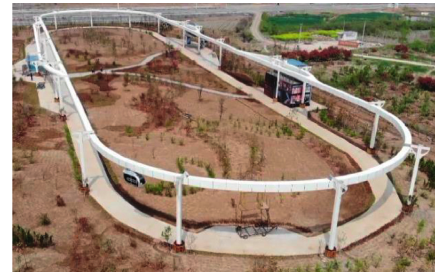
Figure 27: Test equipment.